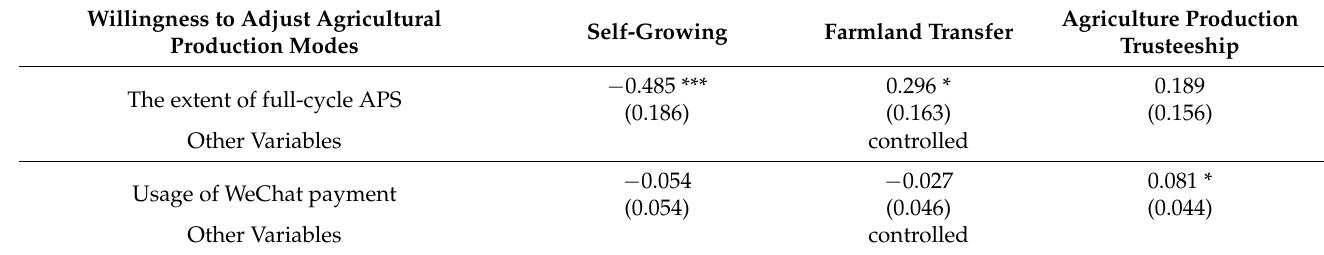
Table 4. Average marginal effects of main